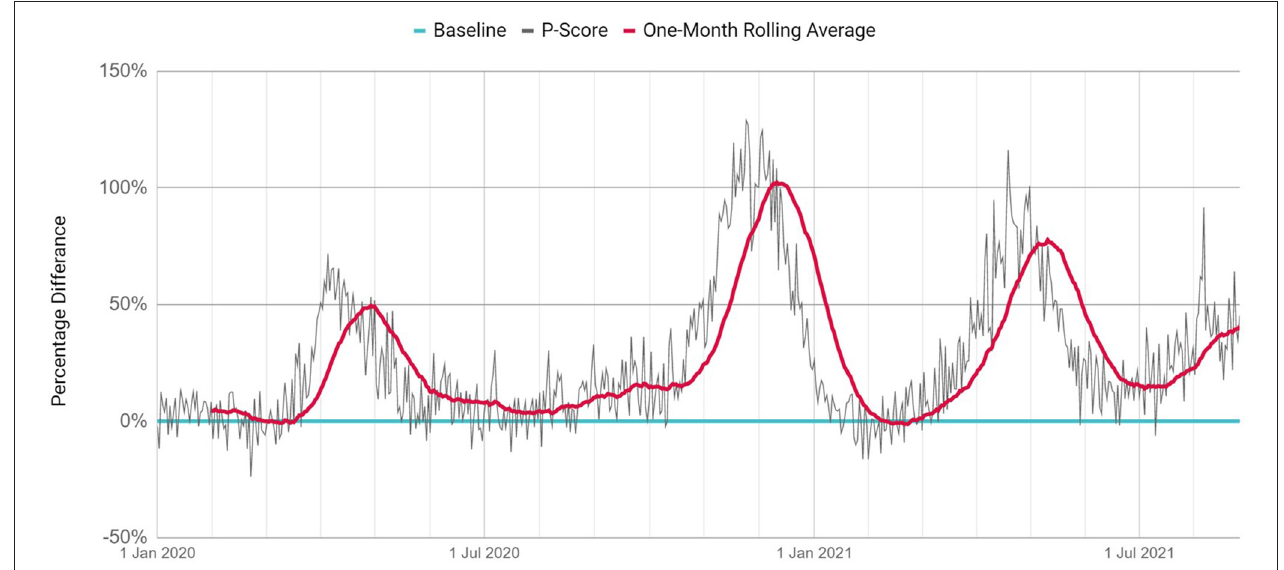
FIGURE 2 | The ratio of excess deaths to expected deaths ( P